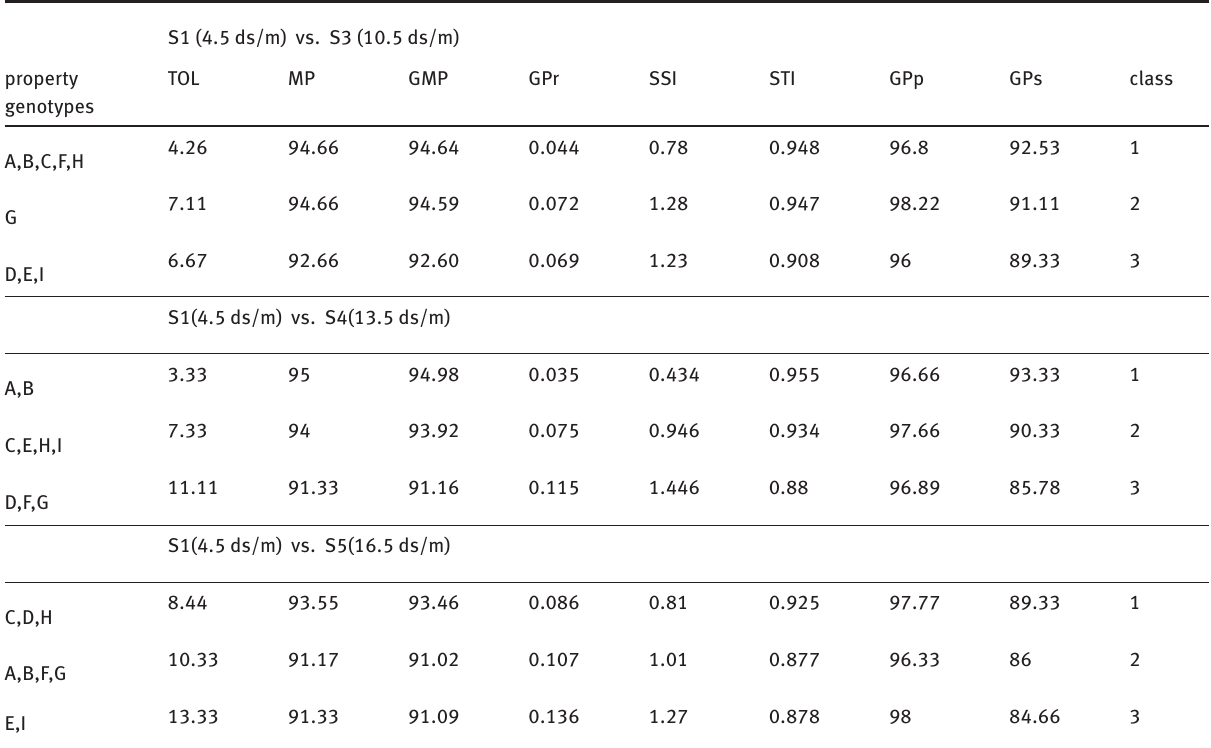
Table 6: Differences of genotype tolerance indices by mean at different salinity levels